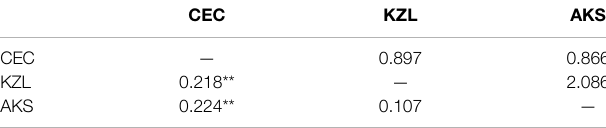
TABLE 5 | Gene fl ow N m (above diagonal) and F st values for pairwise comparison (blow diagonal) among the three populations of Schizothorax biddulphi